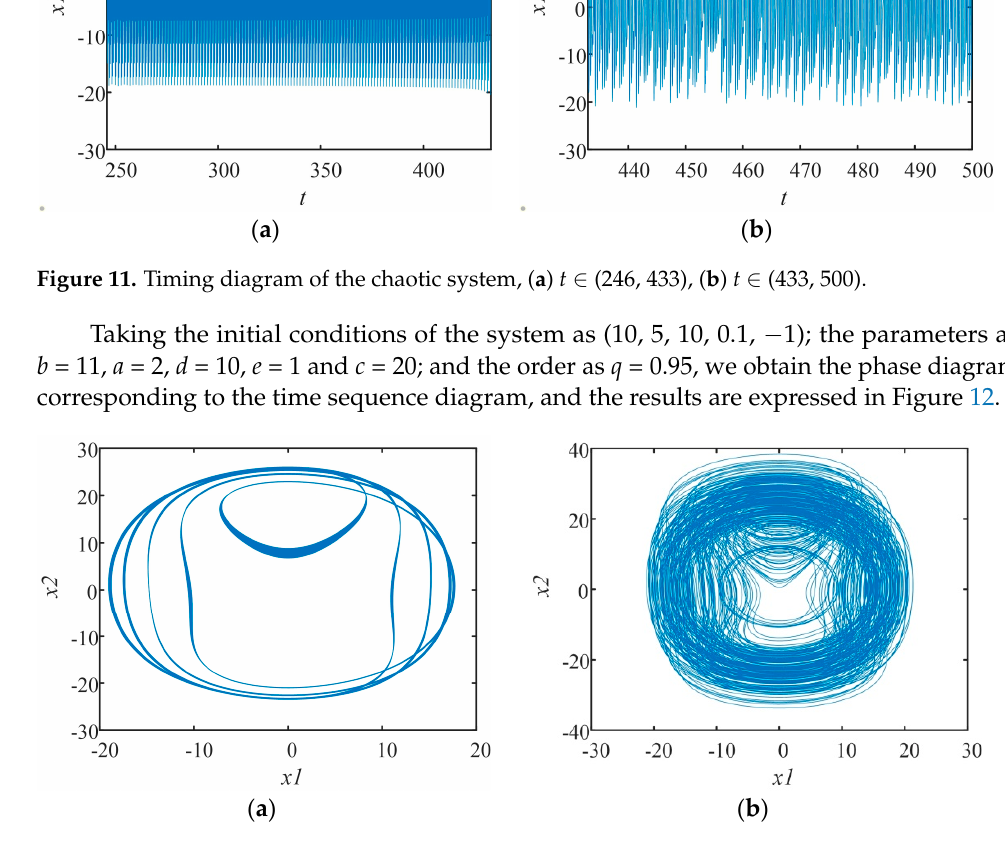
Figure 12. Phase diagram of the chaotic attractor ( a ) t ∈ (246, 433); ( b ) t ∈ (433,